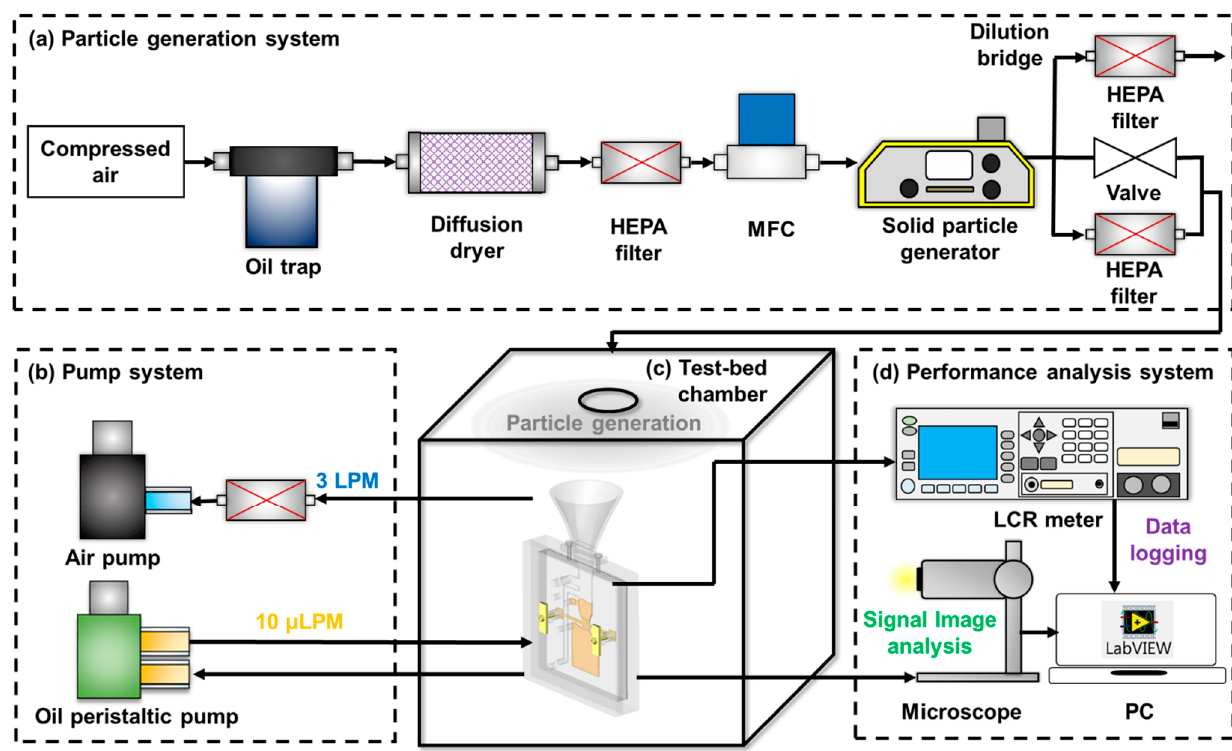
Figure 14. Schematic of the experimental set-up for performance evaluation of the proposed system; ( a ) particle generation system, ( b ) pump system, ( c ) test-bed chamber, and ( d ) performance analysis system.